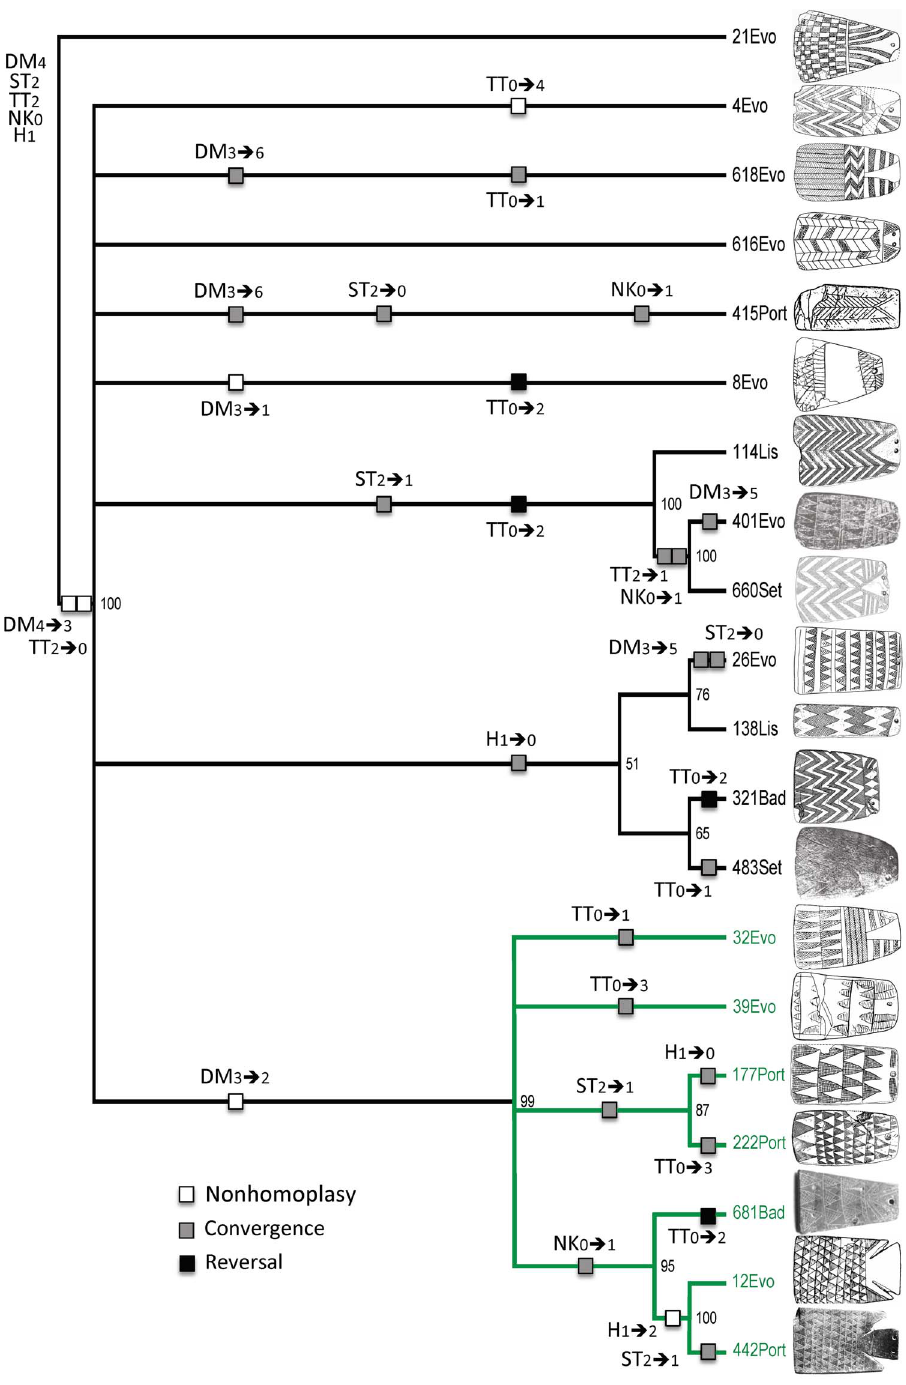
Figure 7. Fifty-percent majority-rule consensus tree from exercise 4, sample 2. The tree, which uses weighted characters and ordered character states, has a CI of 0.147, an RI of 0.554, and an RC of 0.081. Numbers at nodes are bootstrap values.